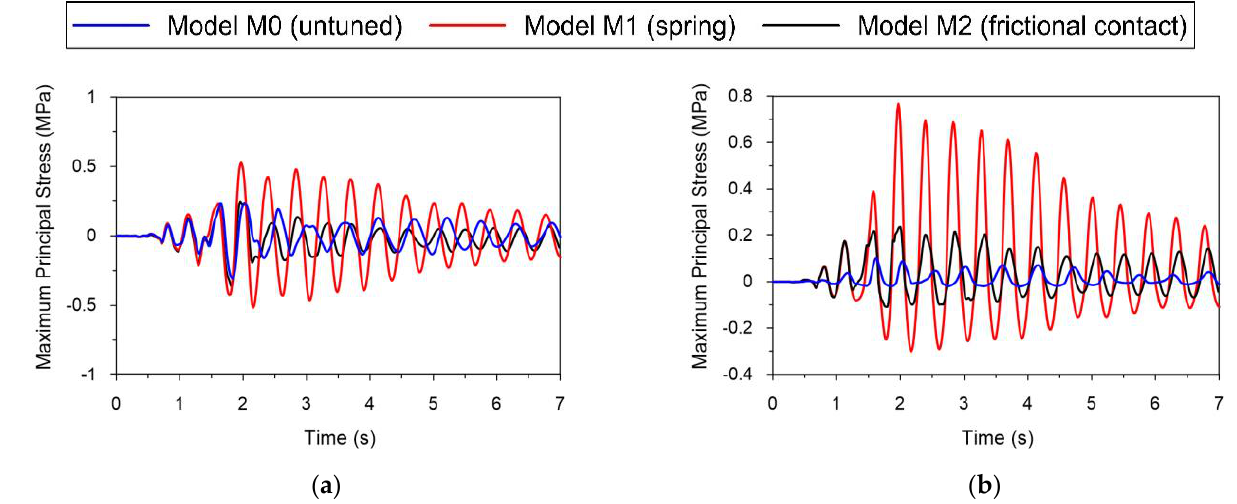
Figure 20. Comparison of stress-time histories of maximal principal stresses obtained for three models of the bridge subjected to the tremor of medium-intensity (D_II) at elements: ( a ) S1 (in the middle of the longest span); ( b ) 3B (above the transversely sliding bearing).